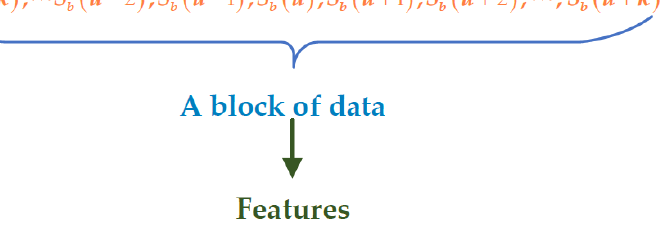
Figure 3. Flowchart of the feature extraction.